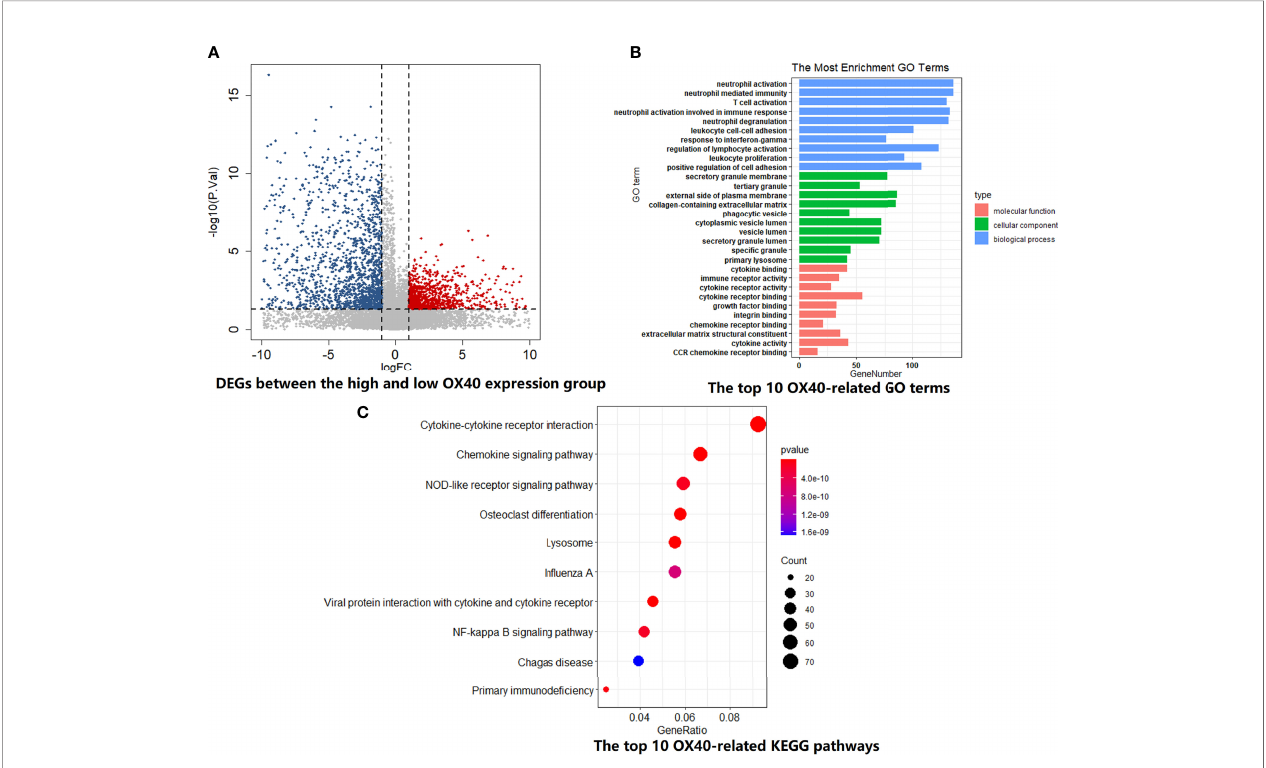
FIGURE 3 | GO and KEGG enrichment analysis for OX40 in SCLC. (A) Differentially expressed genes (DEGs) between the high and low OX40 expression groups were visualized in the volcano plot. (B) The top I0 OX40-relatd GO terms in the fi eld of cellular component, biological process, and molecular function. (C) The top I0 OX40-relatd KEGG pathways. GO, Gene Ontology; KEGG, Kyoto Encyclopedia of Genes and Genomes; SCLC, small cell lung cancer.